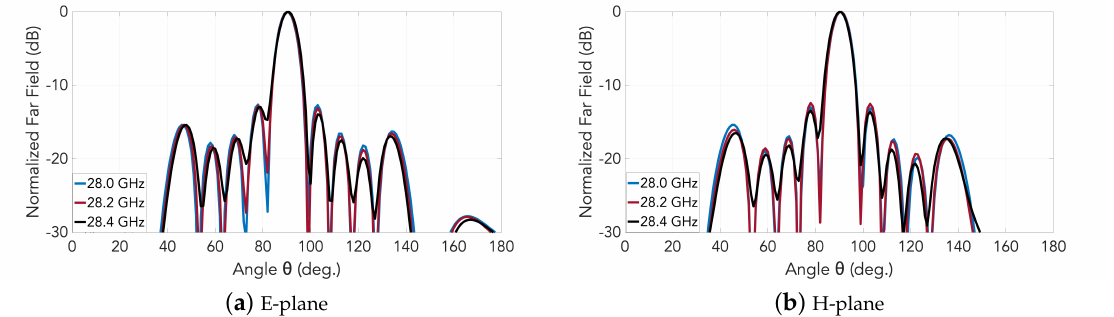
Figure 9. Simulated far-field radiation patterns of the 2D transverse waveguide slot array with horns.